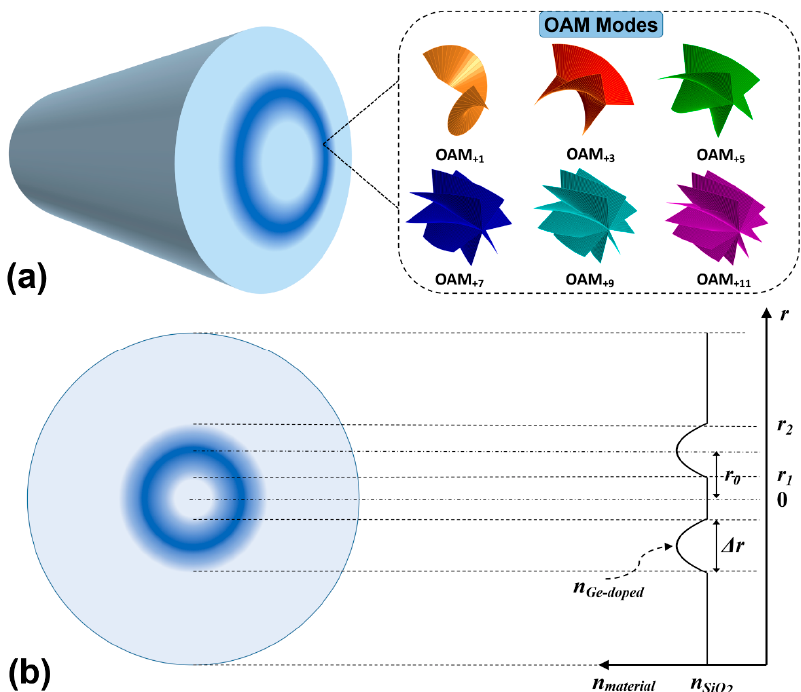
Figure 1. ( a ) Concept of OAM mode-division multiplexing in the proposed GIRCF; ( b ) cross-section view and refractive index profile of the proposed GIRCF.